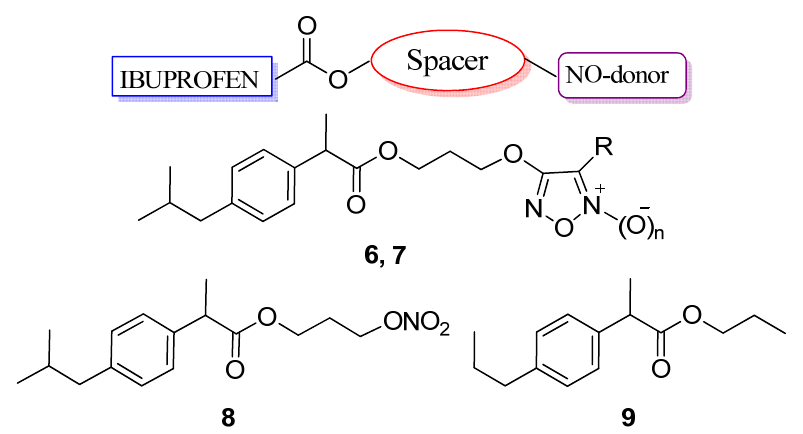
Figure 13. Hybrid ibuprofen/NO donor compounds ( 6 n = 1, R = PhSO R = PhSO ; 7 n = 1, R = PhS; 7a n = 0, R = 2